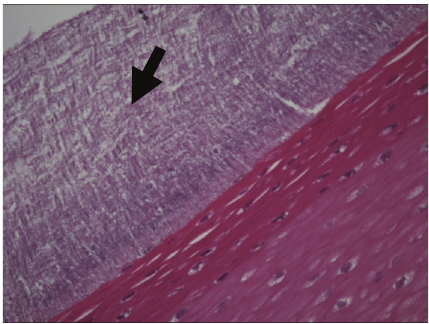
Figure 8: Algae adhered to the superficial epithelium of KMS 389. Algae are arranged in dense